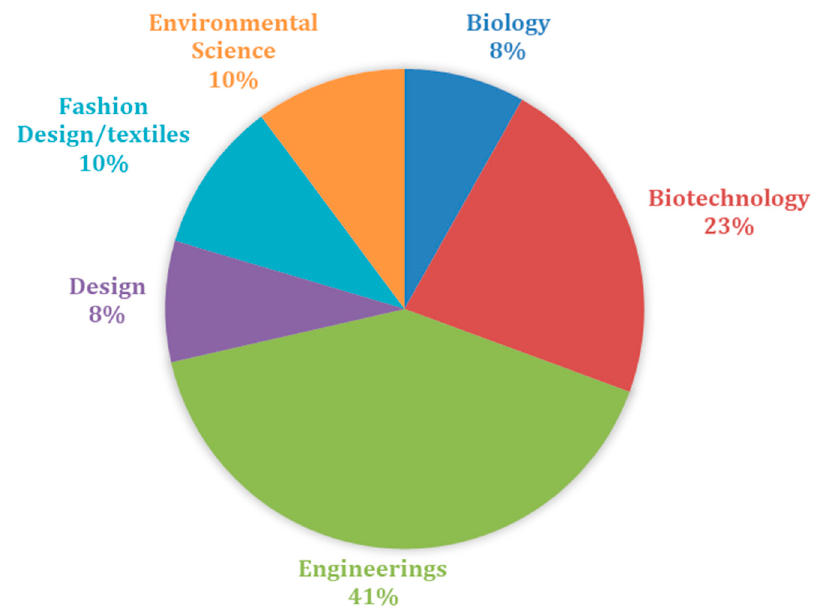
Figure 4. Analysis of the participation of the research areas of the 42 articles that make up the portfolio. Source: authors, 2022.